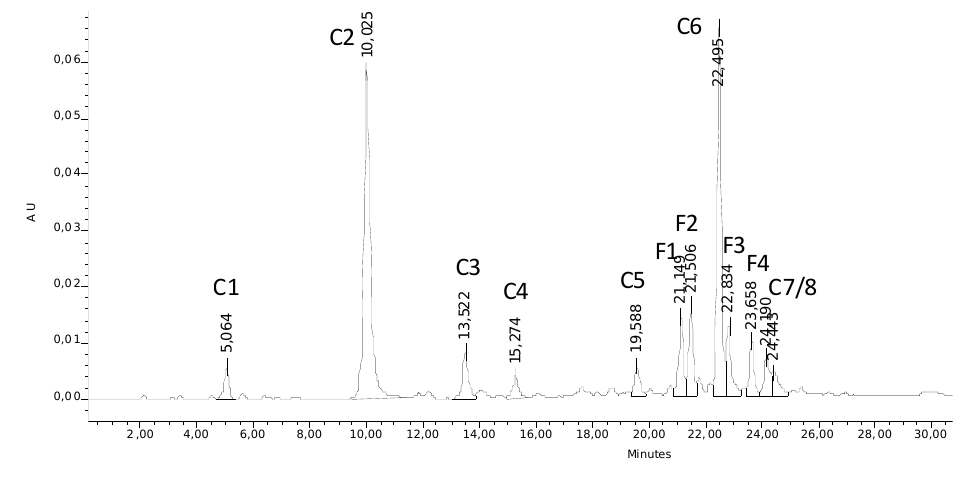
Figure 1: RP-HPLC chromatogram of the ethyl acetate fraction obtained from a partition of a MeOH/water extract from E. perfoliatum ; detection wavelength 325 nm. Peaks C1 to C8 correspond to caffeic acid derivatives, peaks F1 to F4 correspond to